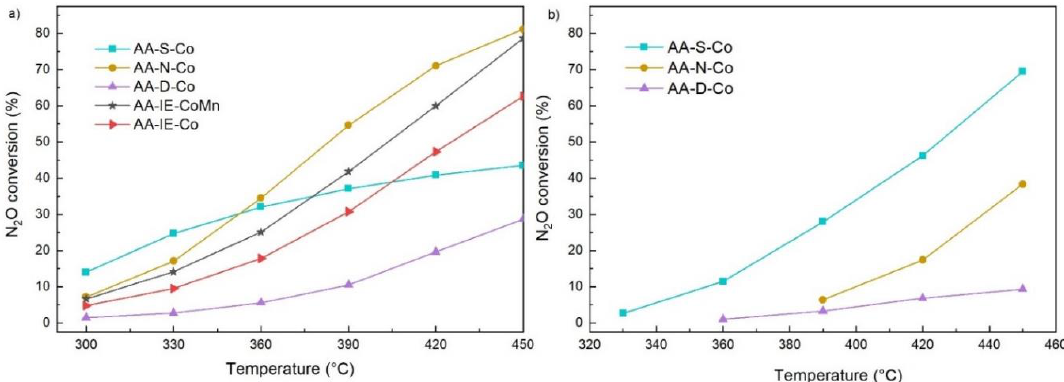
Figure 7. N 2 O conversions over pellets of catalysts at GHSV of 3000 m 3 m bed−3 h −1 (5.1 m 3 kg −1 h −1 for AA-S-Co, 5.8 m 3 kg − 1 h − 1 for AA-N-Co and 6.1 m 3 kg − 1 h − 1 for AA-D-Co) ( a ) and crushed catalyst at AA-S-Co, 5.8 m 3 kg −1 h −1 for AA-N-Co and 6.1 m 3 kg −1 h −1 for AA-D-Co) ( a ) and crushed catalyst at GHSV GHSV 20 m 3 kg − 1 h − 1 ( b 20 m 3 kg −1 h −1 ( b ).